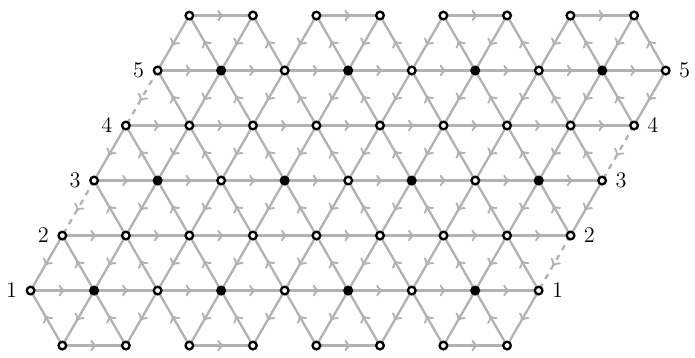
Figure 10 . A cylindrical moose lattice with k = 4 × 3 unit cells, periodic in the horizontal direction. The labels j = 1 . . . 5 indicate that the SU( N ) j nodes on the left and right boundaries are identical. Dashed lines indicate that a quark (for example, the bifundamental of SU( N ) 1 × SU( N ) 2 ) appears twice on the